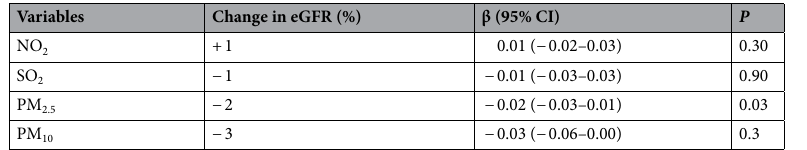
Table 7. Log linear regression model. Estimated associations of the increase by interquartile range of weekly air pollution and estimated glomerular filtration rate. Model was adjusted for seasonality and long-time trends, weather conditions: temperature, humidity, atmospheric pressure, age, gender, and clinical variables including obesity, atrial fibrillation, hyperlipidemia, diabetes mellitus, arterial hypertension. Abbreviations : NO 2 , nitrogen dioxide; PM 2.5 , particulate matter with a diameter of 2.5 μm or less; PM 10, particulate matter with a diameter of 10 μm or less; SO 2 , sulfur